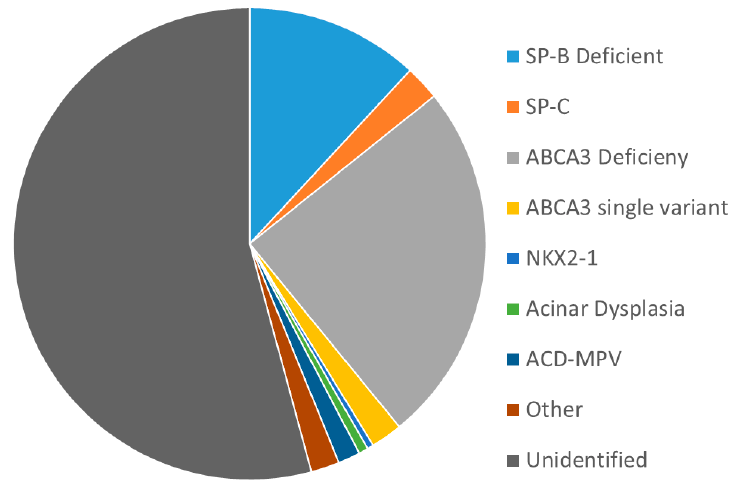
Figure 1. Analysis of 463 infants with severe, diffuse neonatal lung disease, 1995–2016. Analyses were focused on surfactant-related genes. Complete analyses could not be performed on all subjects as the number of genes to be analyzed included in the consent evolved over time, and retrospective analyses for genes not included in more limited consents were not performed, or insufficient samples remained. A genetic mechanism was identified in 44% of subjects.